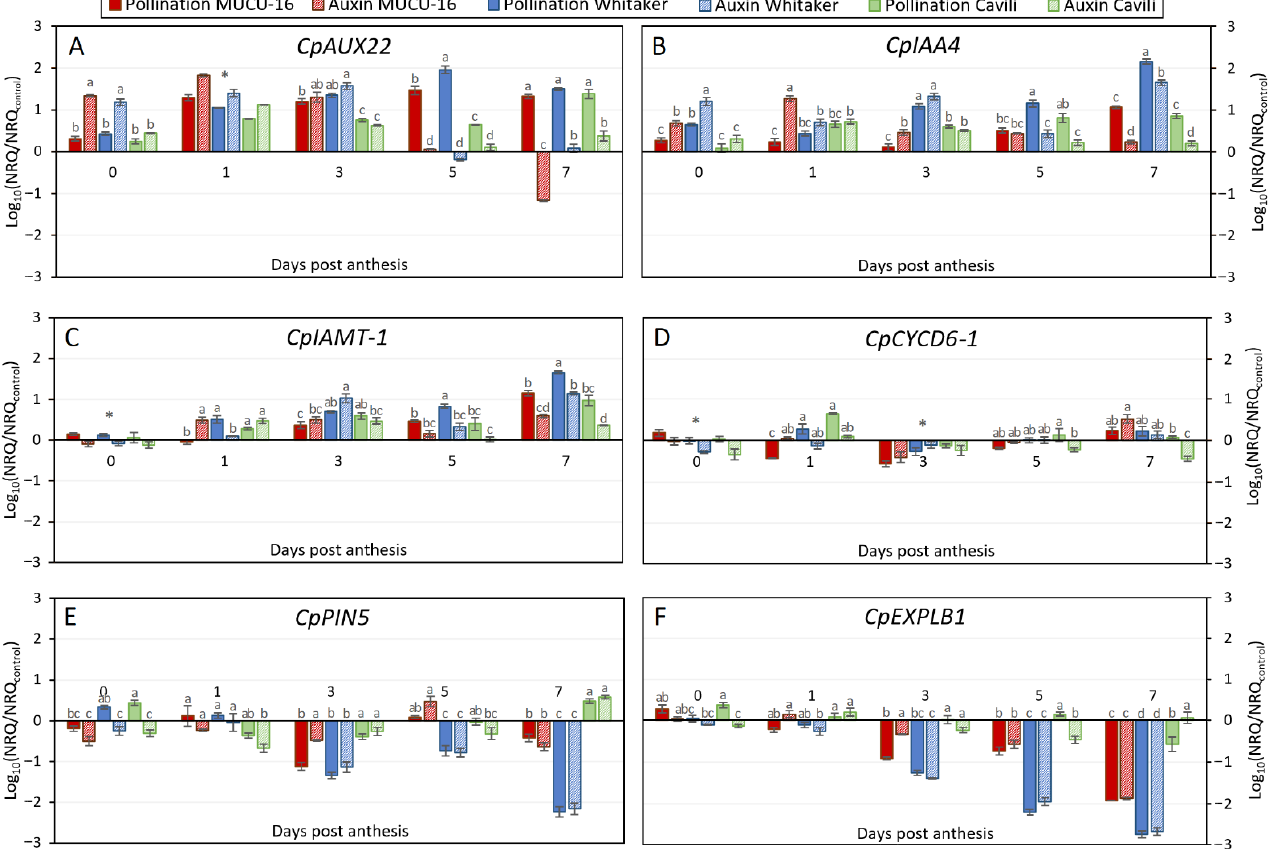
Figure 4. Differential gene expression after treatments in each genotype by day post anthesis. Data is represented by the Normalized relative quantities (NRQ) relativization of pollination and auxin-treatment versus the non-treated (NRQ control) with a logarithmic transformation: Log 10 (NRQ treatment /NRQ control ). Positive values represent more expression in each sample than in the non-treated control, while negative values represent more expression in the non-treated control. Each unit is a 10-fold expression differential. ( A ) ( CpAUX22 , auxin-induced protein AUX22-like), ( B ) ( CpIAA4 , auxin-responsive protein IAA4-like), ( C ) ( CpIAMT-1 , indole-3-acetate O- methyltransferase 1-like), ( D ) ( CpPIN5 , auxin efflux carrier PIN-FORMED 5-like), ( E ) ( CpCYCD6-1, cyclin D6-1-like) and ( F ) ( CpEXPLB1, expansin-like B1). Significative differences (ANOVA, p < 0.05) are indicated with letters (Tukey HSD). * No significative differences. Error bars are standard errors (n = 3).